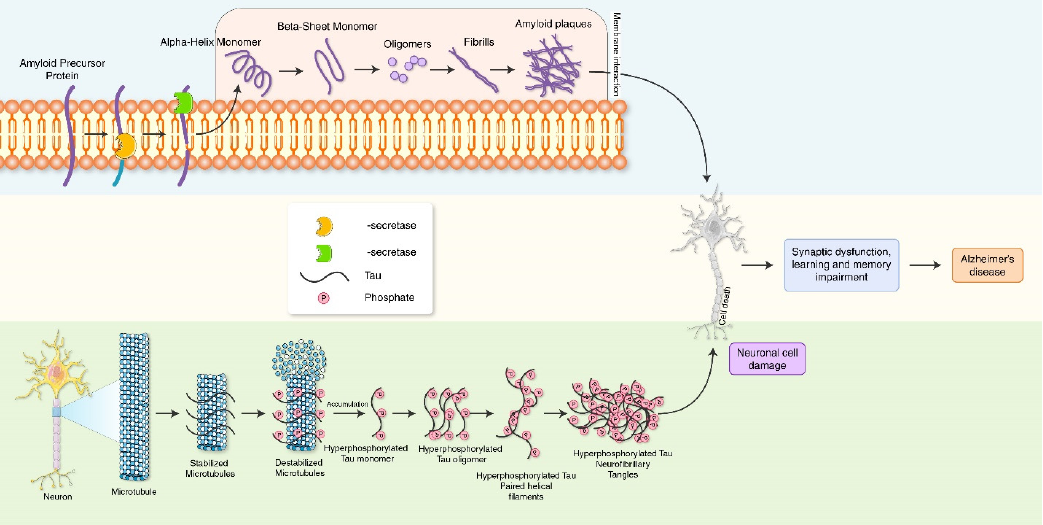
Figure 1. Molecular mechanism of AD pathogenesis. Amyloid precursor protein cleaves by β - secretase and α -secretase, leading to the accumulation of neurotoxic A β plague. Neurofibrillary tangles (NFTs) are aggregates of hyperphosphorylated tau protein. A β plague and NFTs causes synaptic dysfunction and memory impairment, which are characteristics of AD.